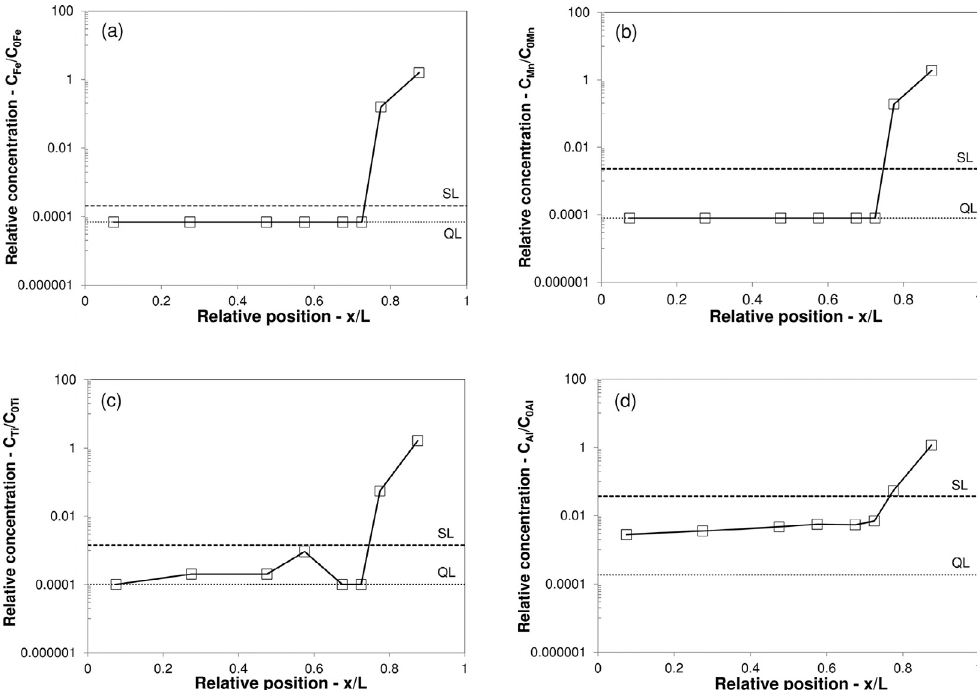
Figure 5. Profiles of relative concentration measured by ICP-MS along the axial direction at the ingot center for (a) Fe, (b) Mn, (c) Ti, and (d) Al as a function of the relative position in relation to the ingot base. The solubility limit (SL) of each element in solid Si and the quantification limit of the ICP analyses (QL) are also